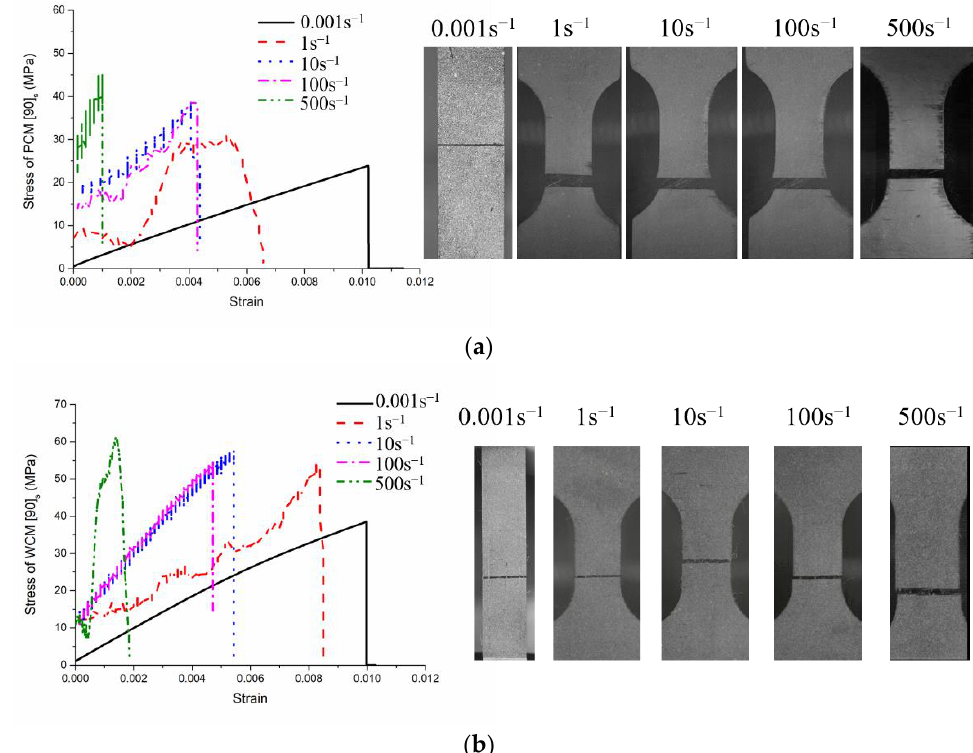
Figure 4. Tensile stress–strain curve and fracture images of (90)s configuration made using ( a ) PCM and ( b ) WCM.